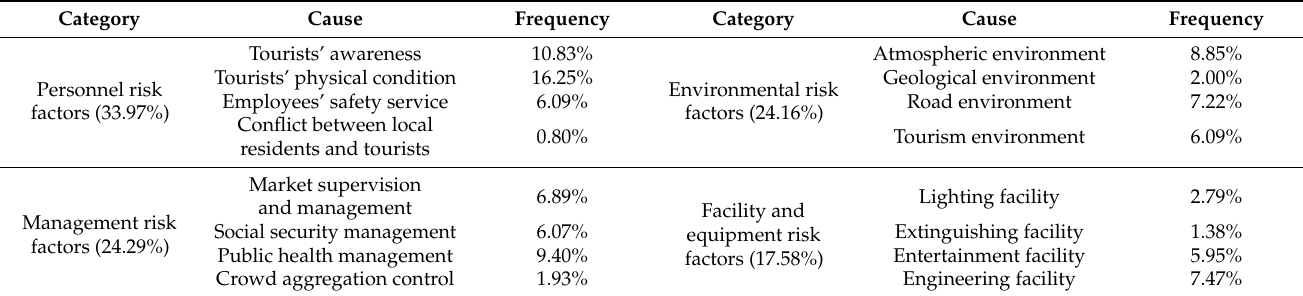
Table 5. Statistics of risk factors of nighttime tourism safety accidents.